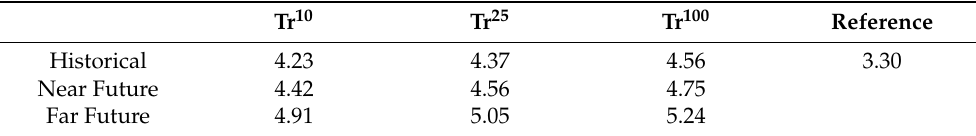
Table 1. The return period of 10- (Tr 10 ), 25- (Tr 25 ), and 100- year (Tr 100 ), and reference for extreme sea levels (meters) with the predicted sea-level rise and considering a simultaneously high tide and storm surge. Tr 10 Tr 25 Tr 100 Reference Historical 4.23 4.37 4.56 3.30 Near Future 4.42 Far Future